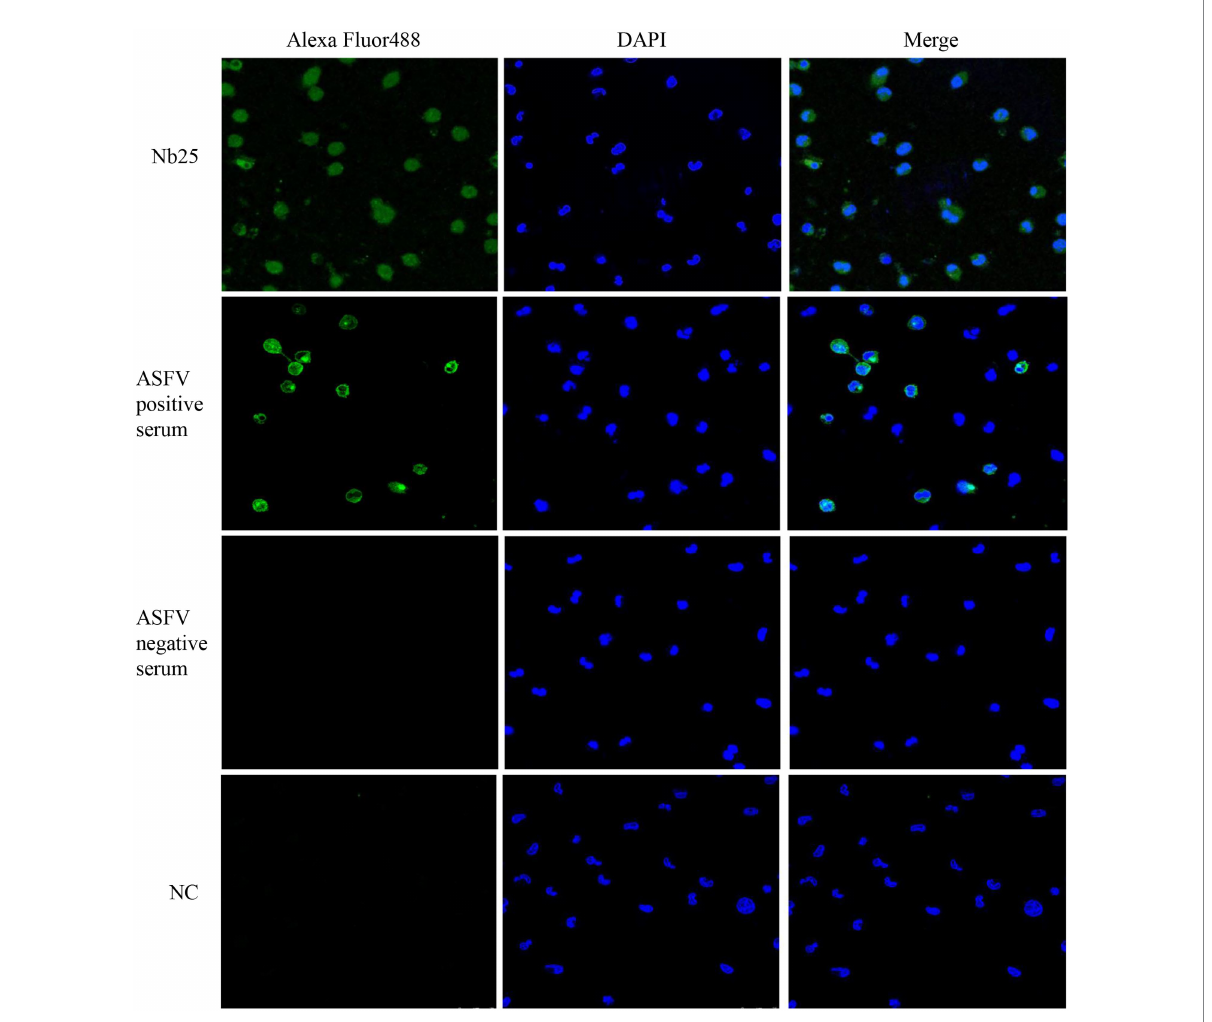
FIGURE 5 Nb25 as biosensor in imaging ASFV in PAM cells. The PAM cells were immobilized at 48 h post ASFV infection, virus free PAM cells were used as a negative control (NC). ASFV in PAM cells was detected by immunofluorescence assay based on FITC-Nb25, ASFV-positive and -negative serum. ASFV free PAM cells were used as negative control (NC). Nucleus were stained with